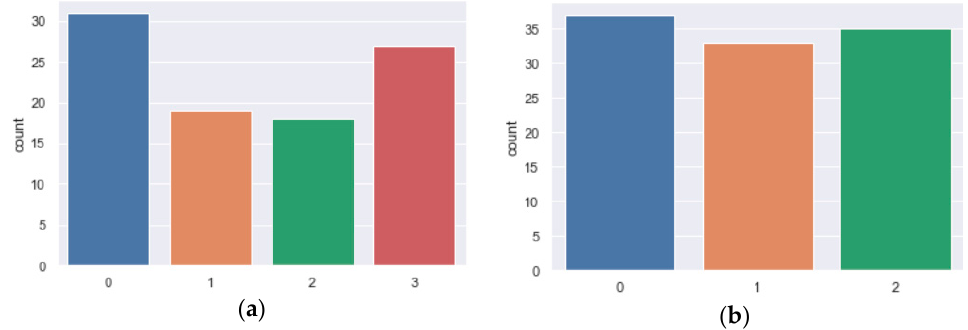
Figure 5. Number of samples by freshness level of ( a ) tuna and ( b ) salmon .